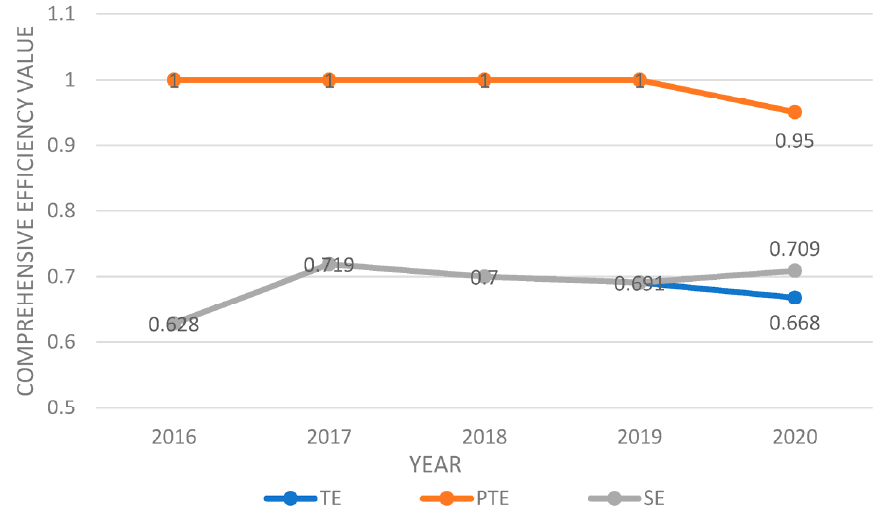
Figure 4. The map of the Yangtze River Delta port group. Trend chart of the comprehensive efficiency of the Yangtze River Delta port group.